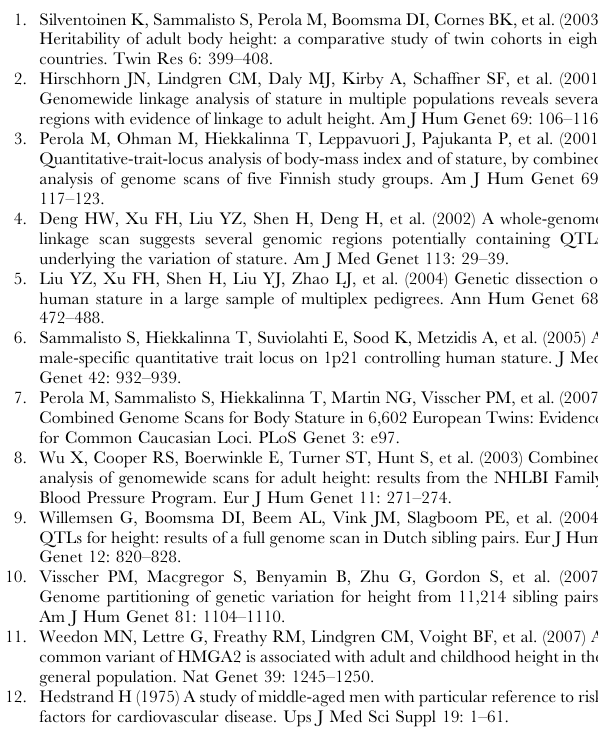
Table S1 Gene, chromosome and nucleotide position for the SNPs analyzed in the ULSAM Illumina